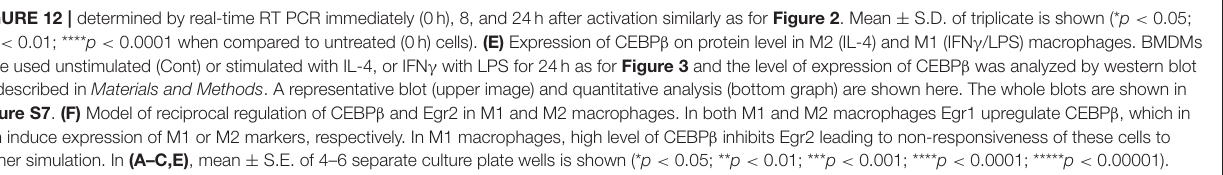
FIGURE 12 | determined by real-time RT PCR immediately (0h), 8, and 24h after activation similarly as for Figure 2 . Mean ± S.D. of triplicate is shown (* p < 0.05; ** p < 0.01; **** p < 0.0001 when compared to untreated (0h) cells). (E) Expression of CEBP β on protein level in M2 (IL-4) and M1 (IFN γ /LPS) macrophages. BMDMs were used unstimulated (Cont) or stimulated with IL-4, or IFN γ with LPS for 24h as for Figure 3 and the level of expression of CEBP β was analyzed by western blot as described in Materials and Methods . A representative blot (upper image) and quantitative analysis (bottom graph) are shown here. The whole blots are shown in Figure S7 . (F) Model of reciprocal regulation of CEBP β and Egr2 in M1 and M2 macrophages. In both M1 and M2 macrophages Egr1 upregulate CEBP β , which in turn induce expression of M1 or M2 markers, respectively. In M1 macrophages, high level of CEBP β inhibits Egr2 leading to non-responsiveness of these cells to further simulation. In (A–C,E) , mean ± S.E. of 4–6 separate culture plate wells is shown (* p < 0.05; ** p < 0.01; *** p < 0.001; **** p < 0.0001; ***** p <